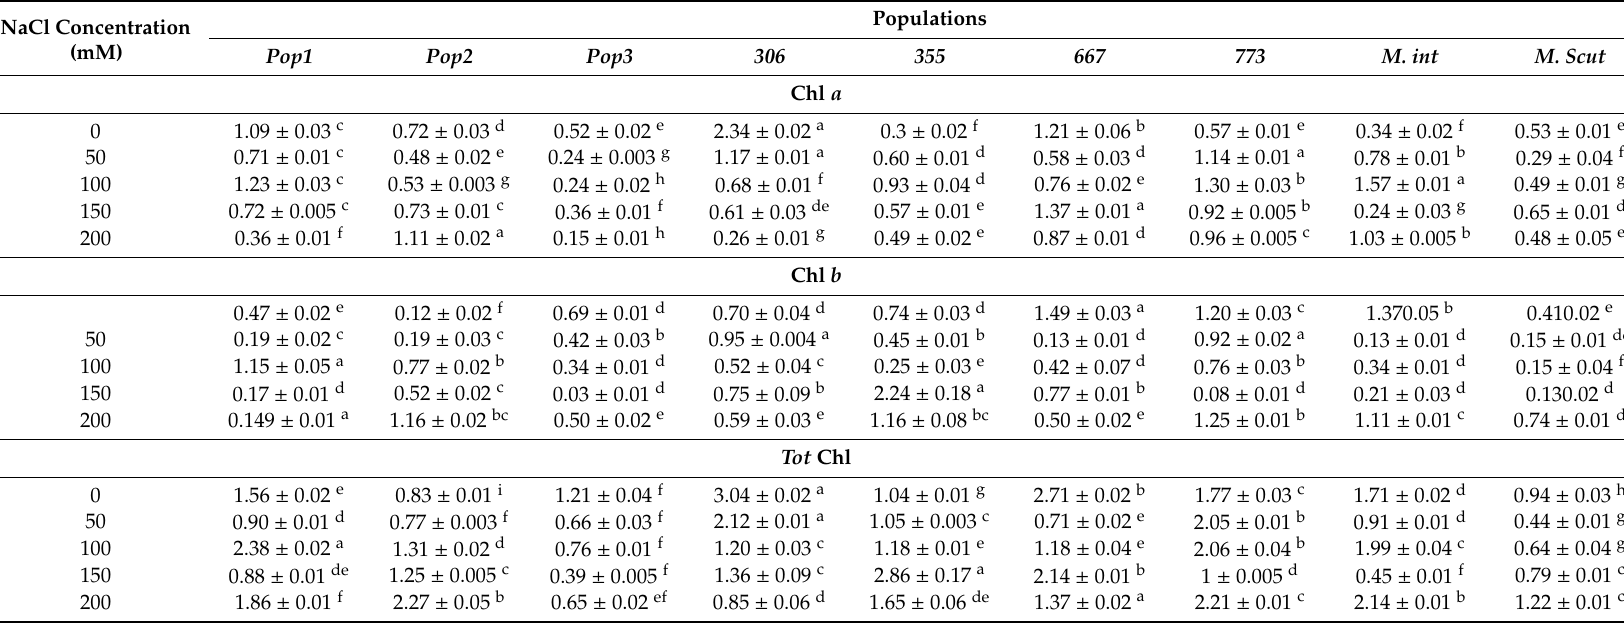
Table 5. E ff ect of salt stress (0, 50, 100, 150, 200 mM NaCl) on leaf chlorophyll content for seven populations of M. ciliaris ( Pop1, Pop2, Pop3, 306, 355, 667, 773 ), compared to one population of M. intertexta ( M. int ) and one population of M. scutellata ( M. scut ). The means are averages of n = 5. The standard deviation annotated by di ff erent lower-case letters in the same stress type indicate significant di ff erences at p < 0.05 according to Tukey’s post hoc test. NaCl